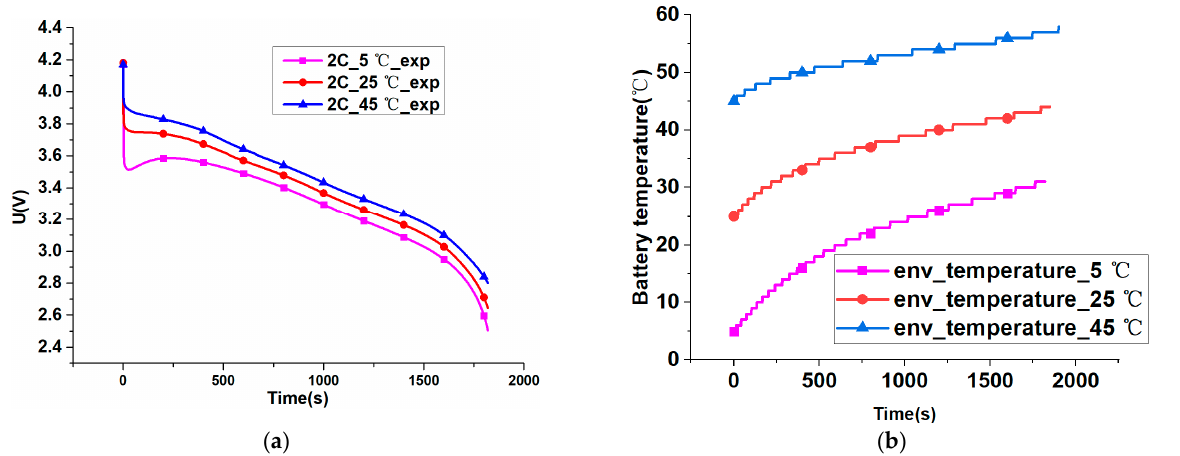
Figure 4. ( a ) Ba tt ery transient terminal voltage varies with discharge depth at di ff erent ambient tem- Figure 4. ( a ) Battery transient terminal voltage varies with discharge depth at different ambient tem- peratures; ( b ) Electrode temperature changes with discharge depth at di ff erent ambient tempera- peratures; ( b ) Electrode temperature changes with discharge depth at different ambient tures.